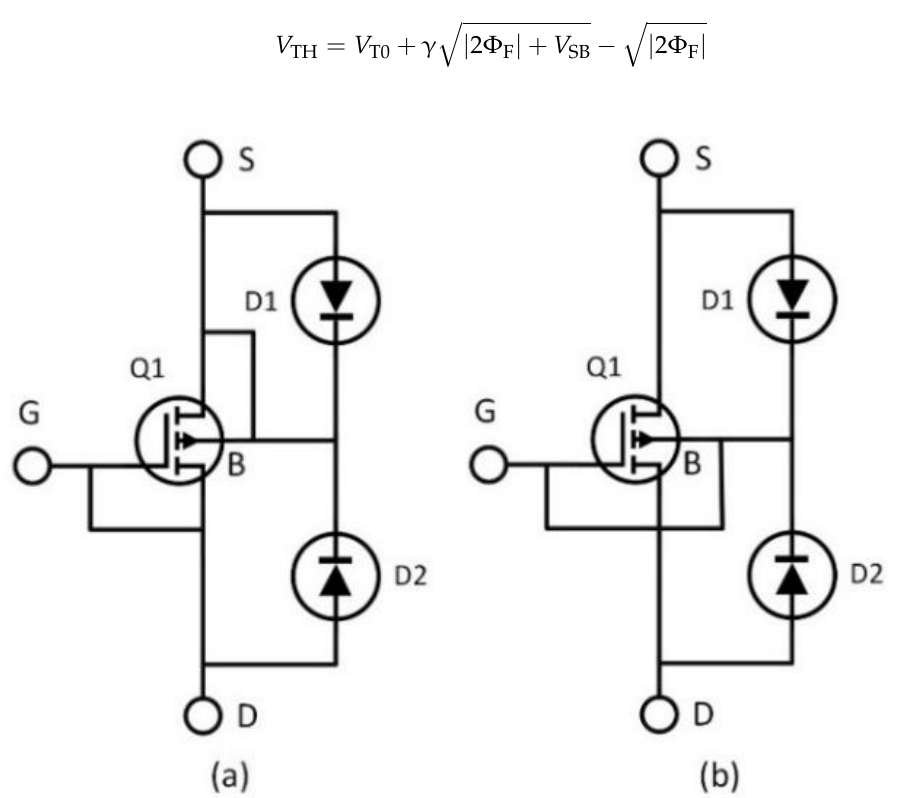
Figure 11. Diode connected transistors: ( a ) BTMOS ( b ) DTMOS. This not only improves power flow but also minimizes reverse leakage current. − 32 dBm.